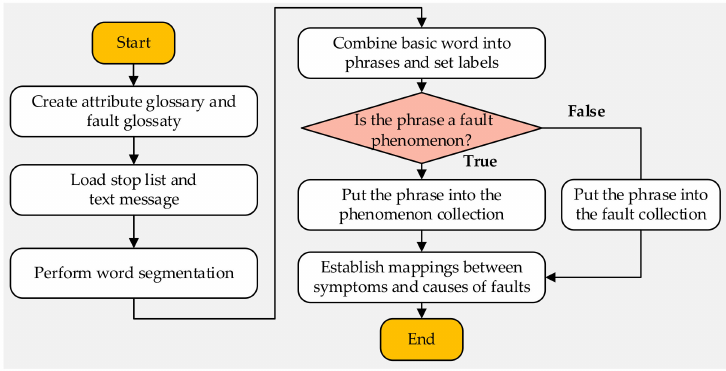
Figure 3. Fault symptom and fault level extraction process.